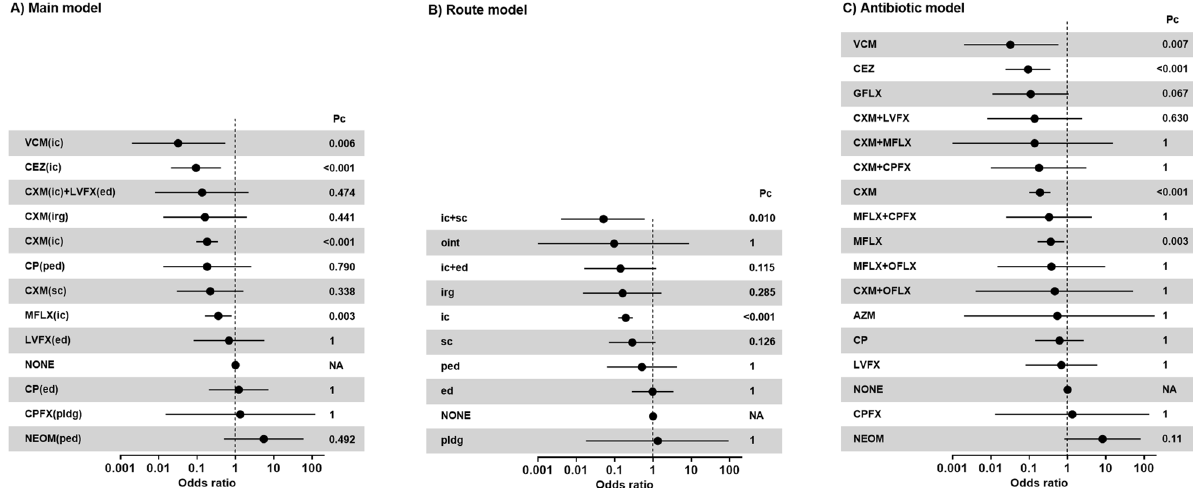
Figure 3. Forest plots. Common comparator was no antibiotic prophylaxis (NONE). Please note that 99.6% confidence interval (CI) for the main model, 99.4% CI for the route model, and 99.7% CI for the antibiotic model were used. Please see Supplementary Table 7 for more detail. Pc, Bonferroni-corrected P value. Please see Supplementary Table 7 for more detail. NONE no prophylactic antibiotics, CEZ cefazoline, CXM cefuroxime,